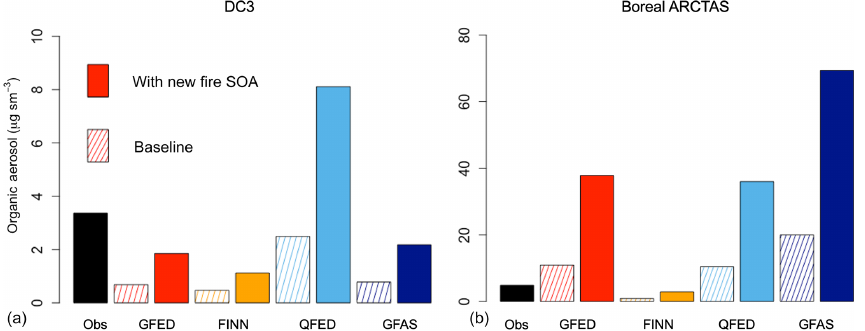
Figure 12. Bar plots of mean OA mass concentrations from the DC3 (a) and boreal ARCTAS (b) campaigns. Observations (black) are compared with simulations using the four fire inventories: GFED4s (red), FINN1.5 (orange), QFED2.4 (light blue), and GFAS1.2 (dark blue). The hatched version of each inventory denotes OA mass concentrations using the baseline fire SOA scheme while the full color of each shows OA with the new SOA from fire